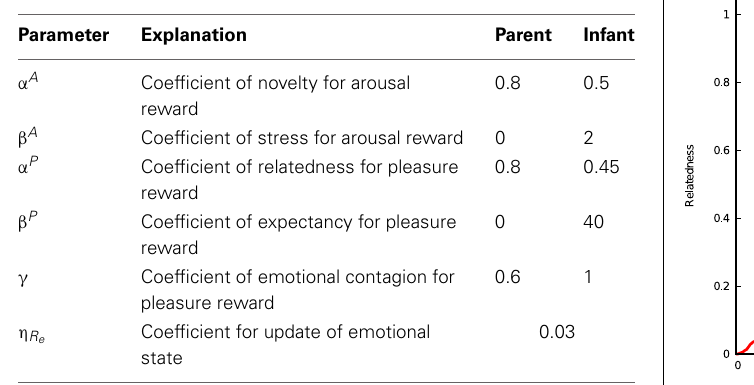
Table 2 | Parameters of emotional change.